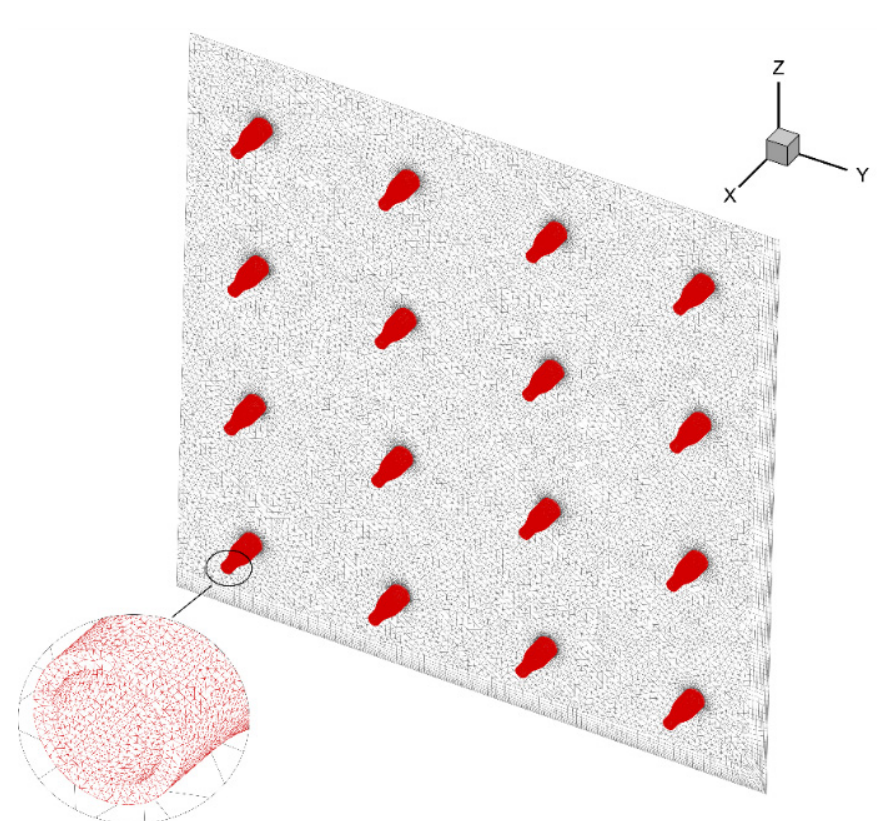
Figure 10. Mesh model of the inlet nozzles.